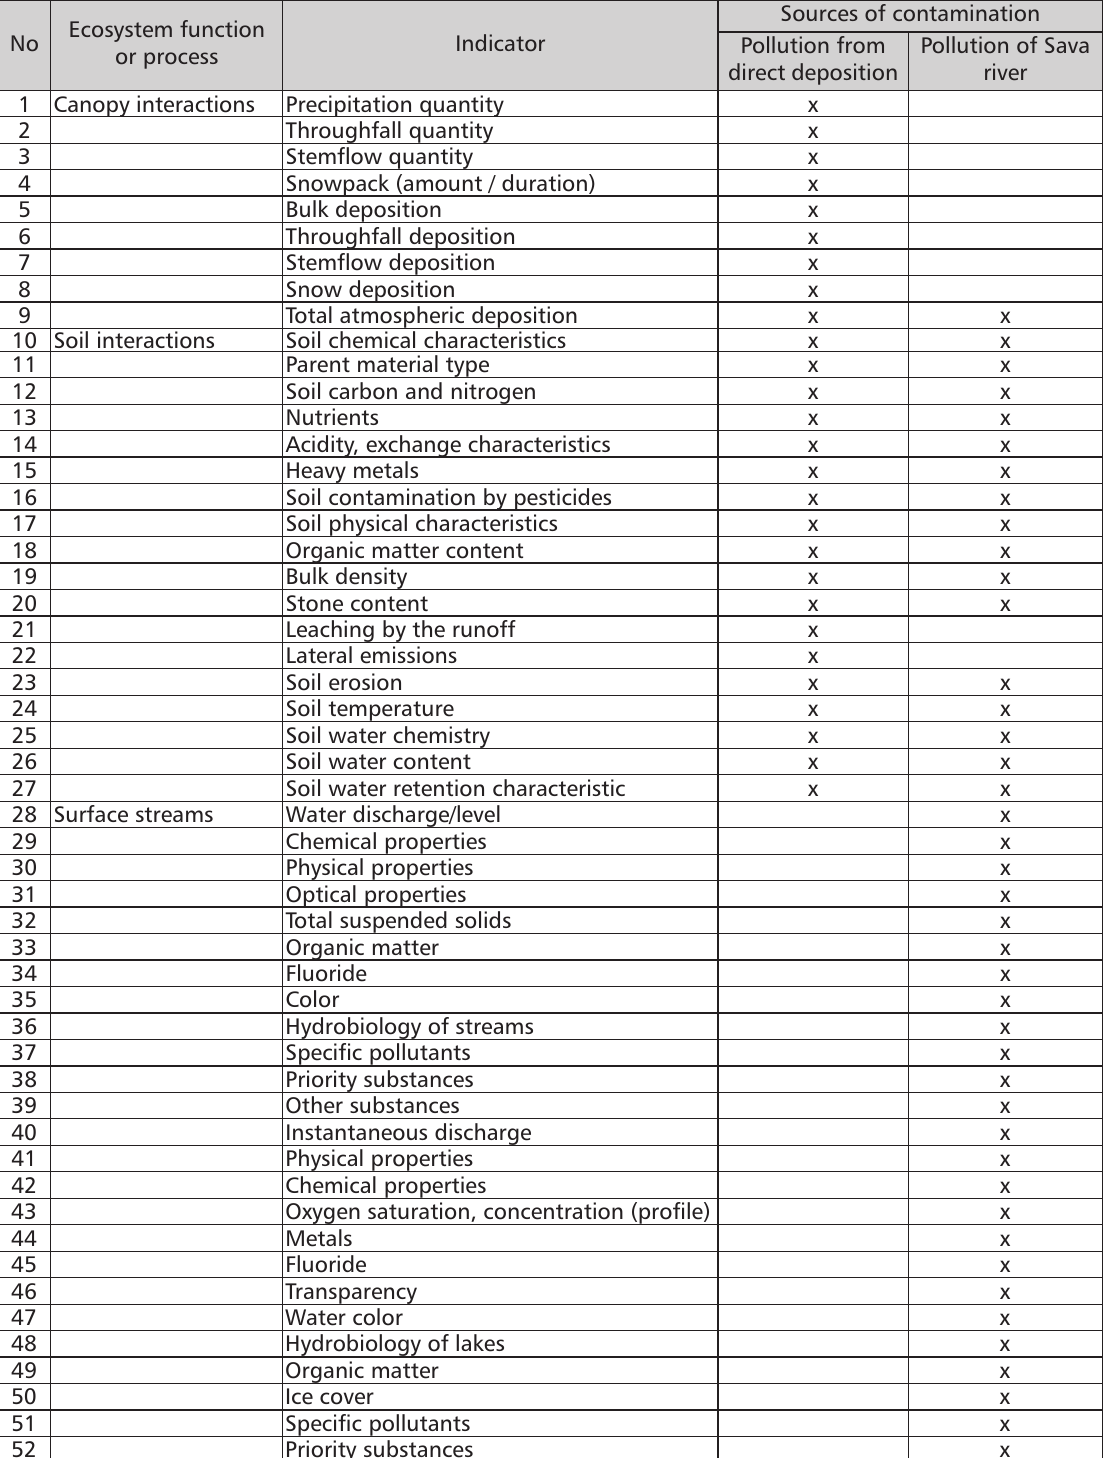
Core indicators for drinking water protection in urban forests of